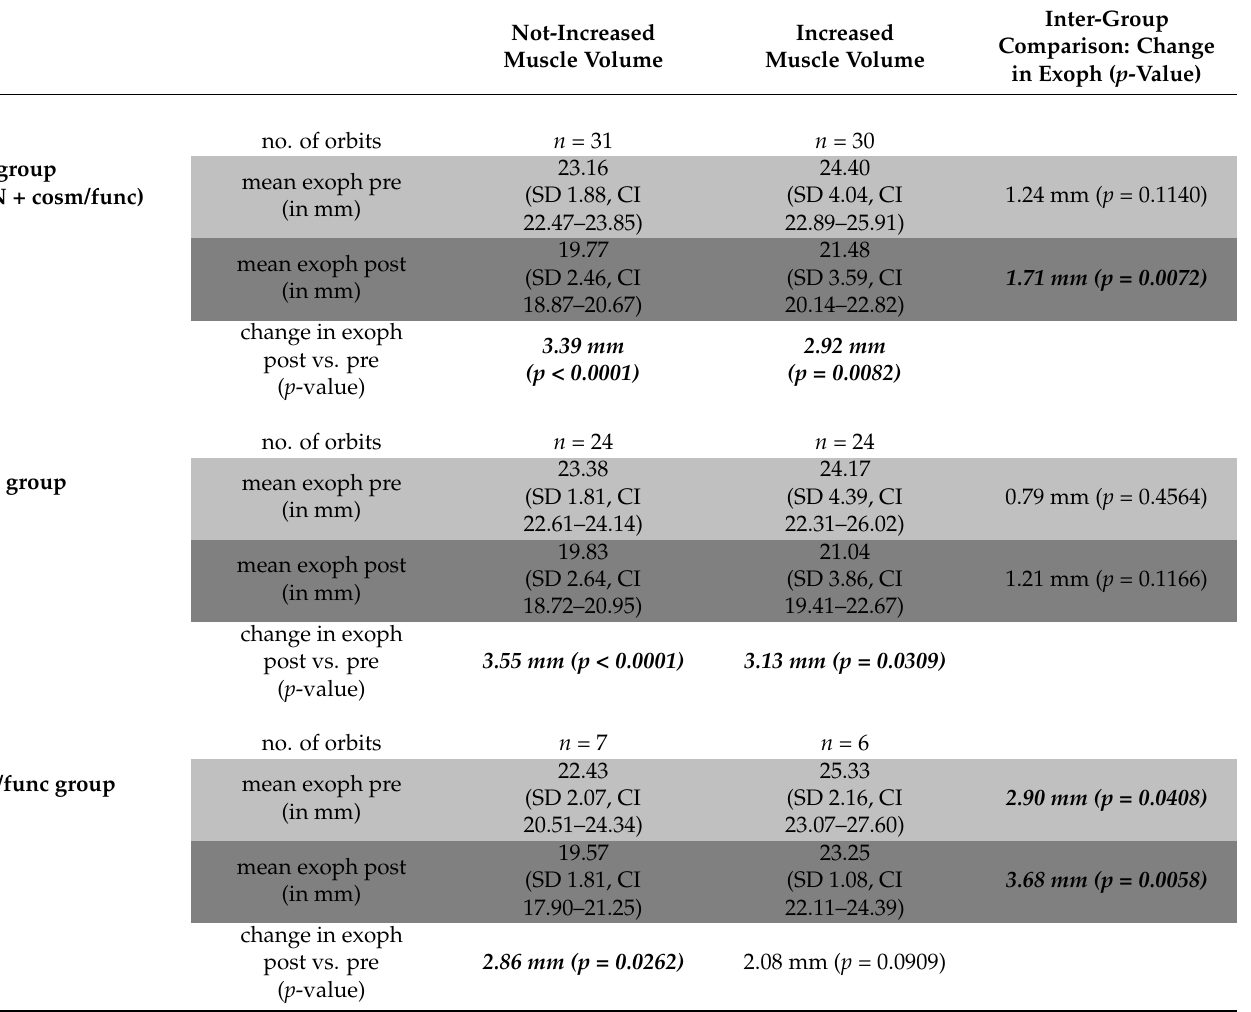
Table 3. Intra- and inter-group statistical analysis of pre- and postoperative exophthalmos (analysis within and between “not-increased” and “increased” orbital muscle volume). Inter-Group Not-Increased Increased Comparison: Change Muscle Volume Muscle Volume in Exoph ( p